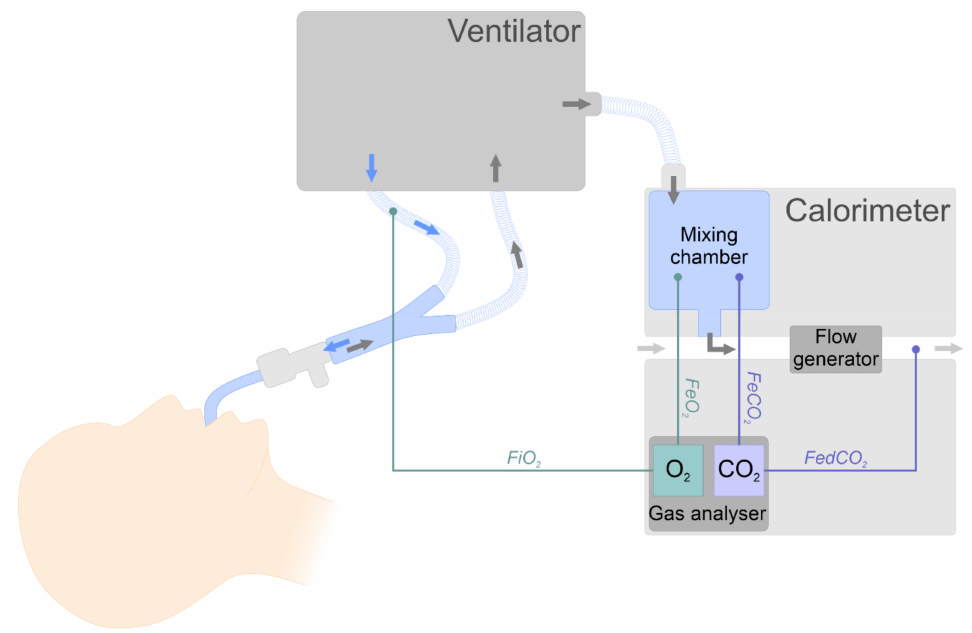
Figure 1. Indirect calorimetry scheme with the use of the mixing chamber technique in a mechanically ventilated patient (based on the Deltatrac Metabolic Monitor ® calorimeter). FiO 2 is measured from the ventilator’s inspiratory limb, while FeO 2 and FeCO 2 are measured from the mixing chamber. The gas from the mixing chamber is removed through a system with a constant flow of gas, in which it is diluted with ambient air. The CO 2 fraction in the diluted exhaust gas (FedCO 2 ) is measured. VCO 2 is calculated as the product of constant flow (Q) and FedCO 2 (VCO 2 = FedCO 2 × Q). VO 2 is calculated using the Haldane transformation. EE is calculated using the Weir equation [10,17]. Abbreviations: CO 2 —carbon dioxide; EE—energy expenditure; FeCO 2 —fraction of exhaled CO 2 ; FedCO 2 —fraction of exhaled CO 2 after dilution; FeO 2 —fraction of exhaled oxygen; FiO 2 —fraction of inhaled oxygen; O 2 —oxygen; Q—flow; VO 2 —volume of consumed oxygen; VCO 2 —volume of produced CO 2